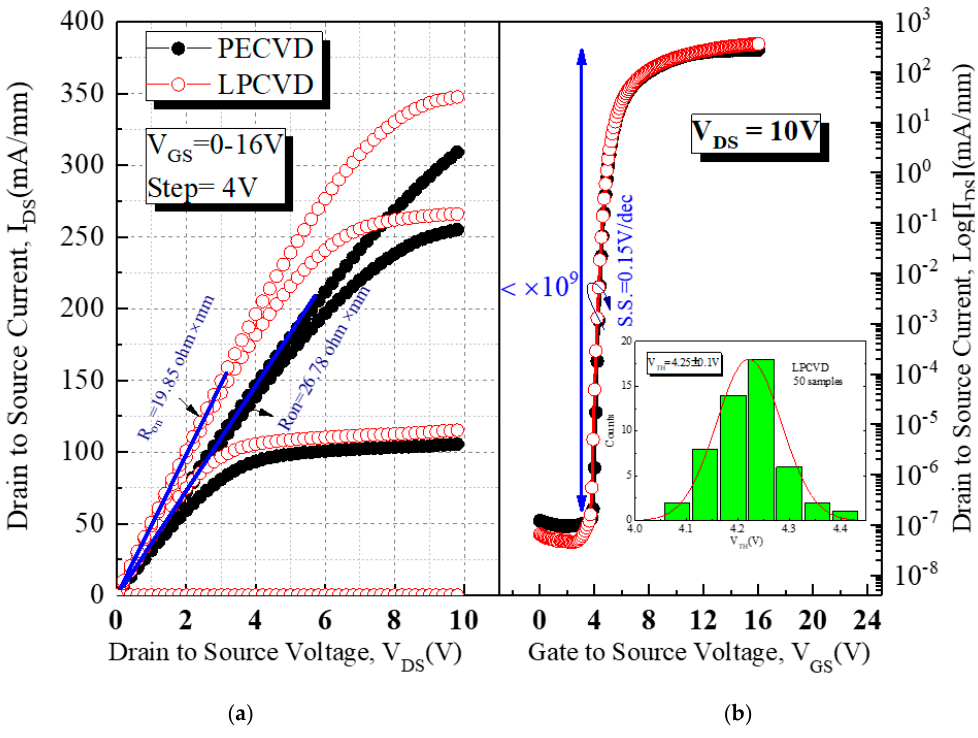
Figure 5. ( a )The I DS -V DS characteristics ( b ) Log-scale I DS -V GS and V TH distribution of both devices.